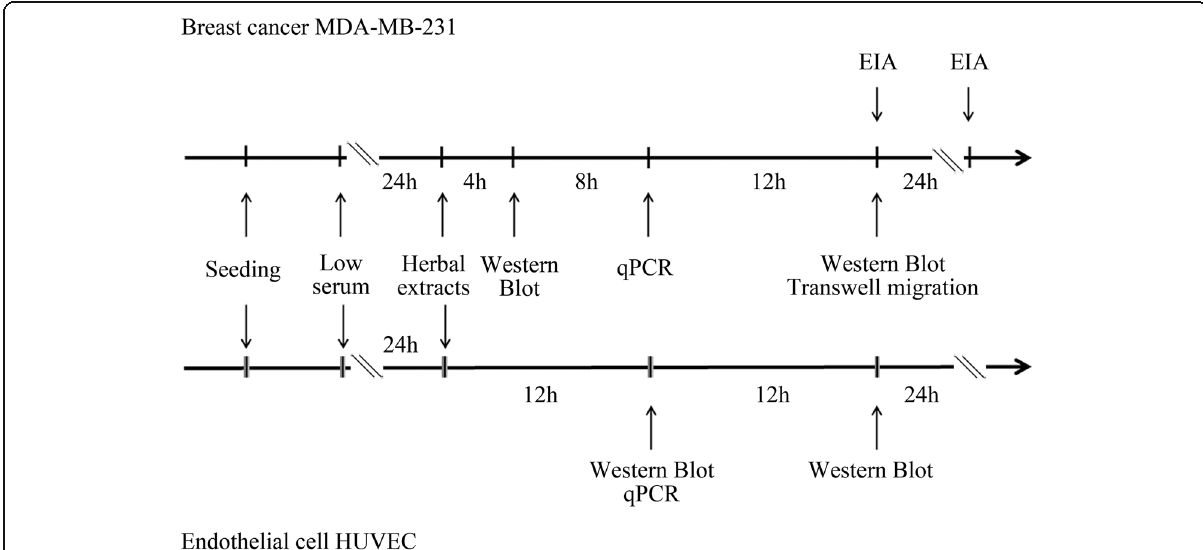
Fig. 1 Experimental protocols. Two systems were used, namely, a triple negative MDA-MB-231 breast cancer cell line and a human umbilical endothelial cell line (HUVEC), for the study of autocrine and paracrine BDNF-TrkB loop